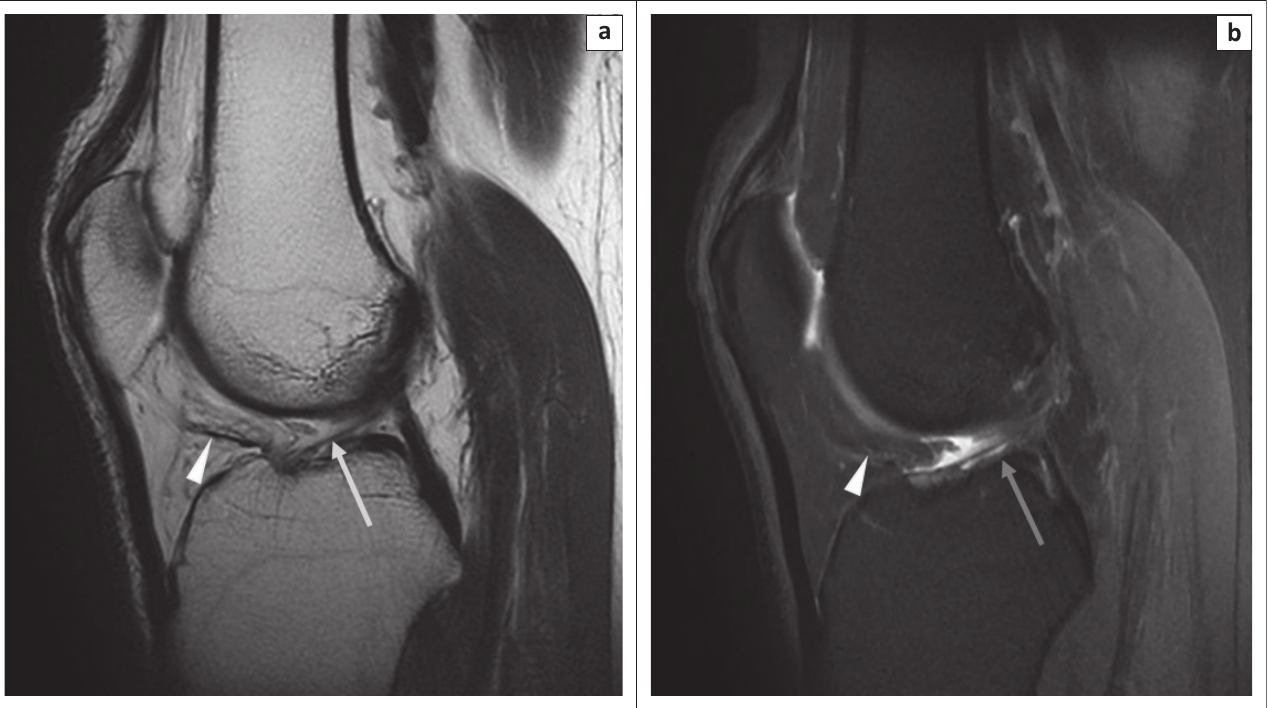
FIG URE 2: Magnetic resonance imaging of a normal infrapatellar plica: sagittal T2-weighted image (T2WI) (a) and sagittal proton density fat-saturated (PDFS) image (b) revealing the normal infrapatellar plica as a thin low-signal intensity structure anterior to anterior cruciate ligament in the inter-condylar notch (arrow) and in Hoffa’s fat pad (arrow